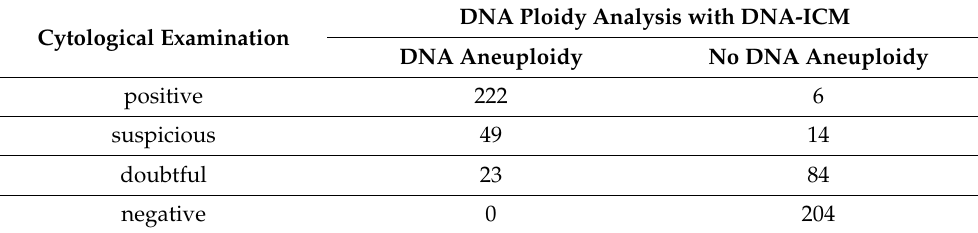
Table 4. Overview of the results of the cytological examination and the DNA-ICM in comparison.